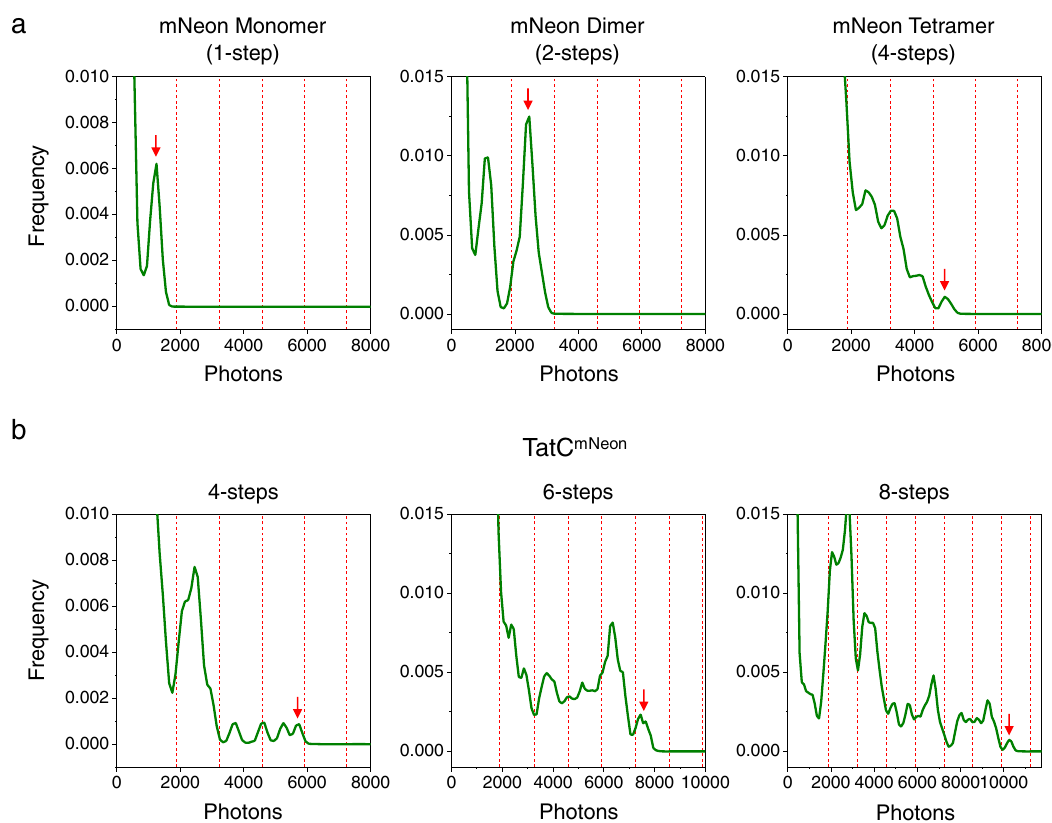
Fig. 5 PDD identi fi cation of mNeon photobleaching steps. a , b PDD histograms for the traces shown in Fig. 4. The last peak (red arrow) was used to determine the number of photobleaching steps in the trace. The boundaries between step assignments (red dashed vertical lines) are described in the Methods and Supplementary Fig. 9b.